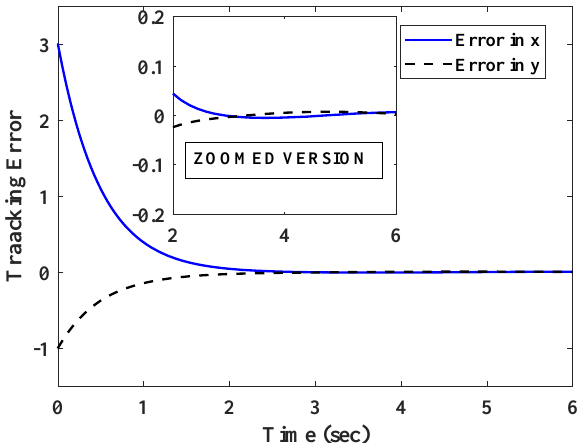
Figure 5. Convergence of X and Y position of robot in presence of slow varying measurement errors.